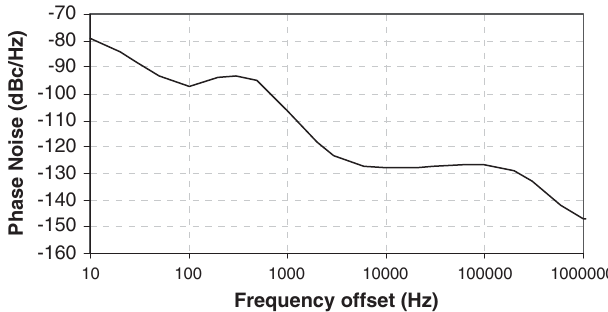
FIG. 10. Replot of Agilent E4428 signal phase noise figure at a carrier frequency of 2.2 GHz.